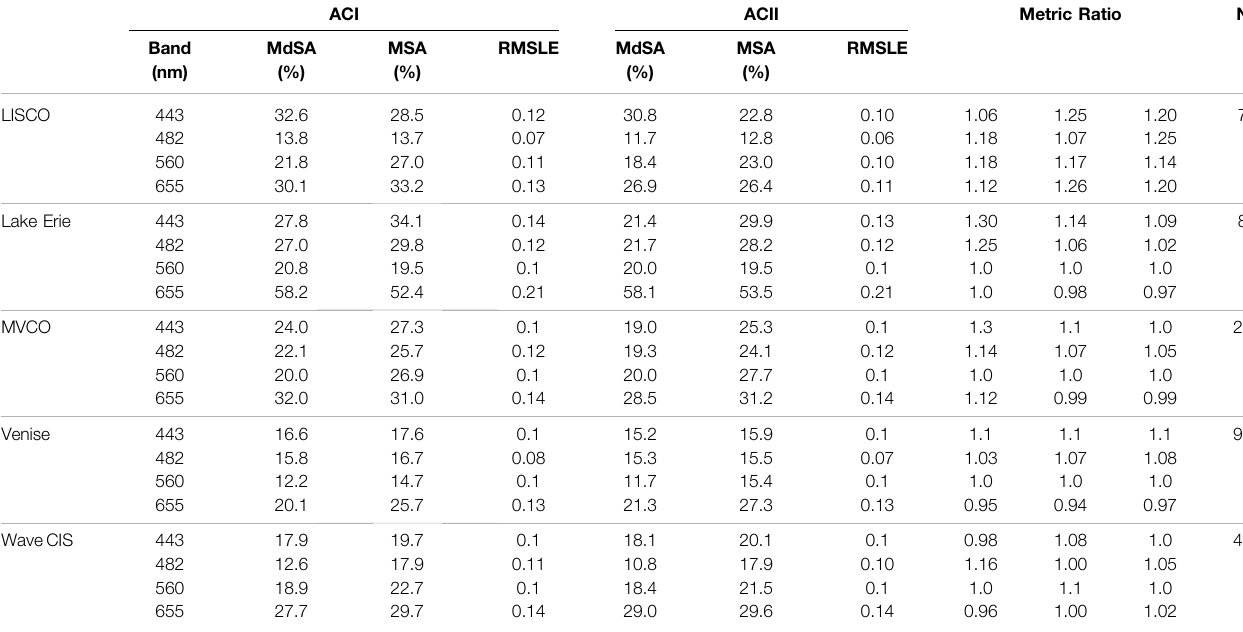
TABLE 6 | Per-site matchup statistics ( Eq. 5 – 7 ) for the performance of our experimental AC processors (ACI and ACII). The number of matchups is provided in the last column. ACI ACII Metric Ratio